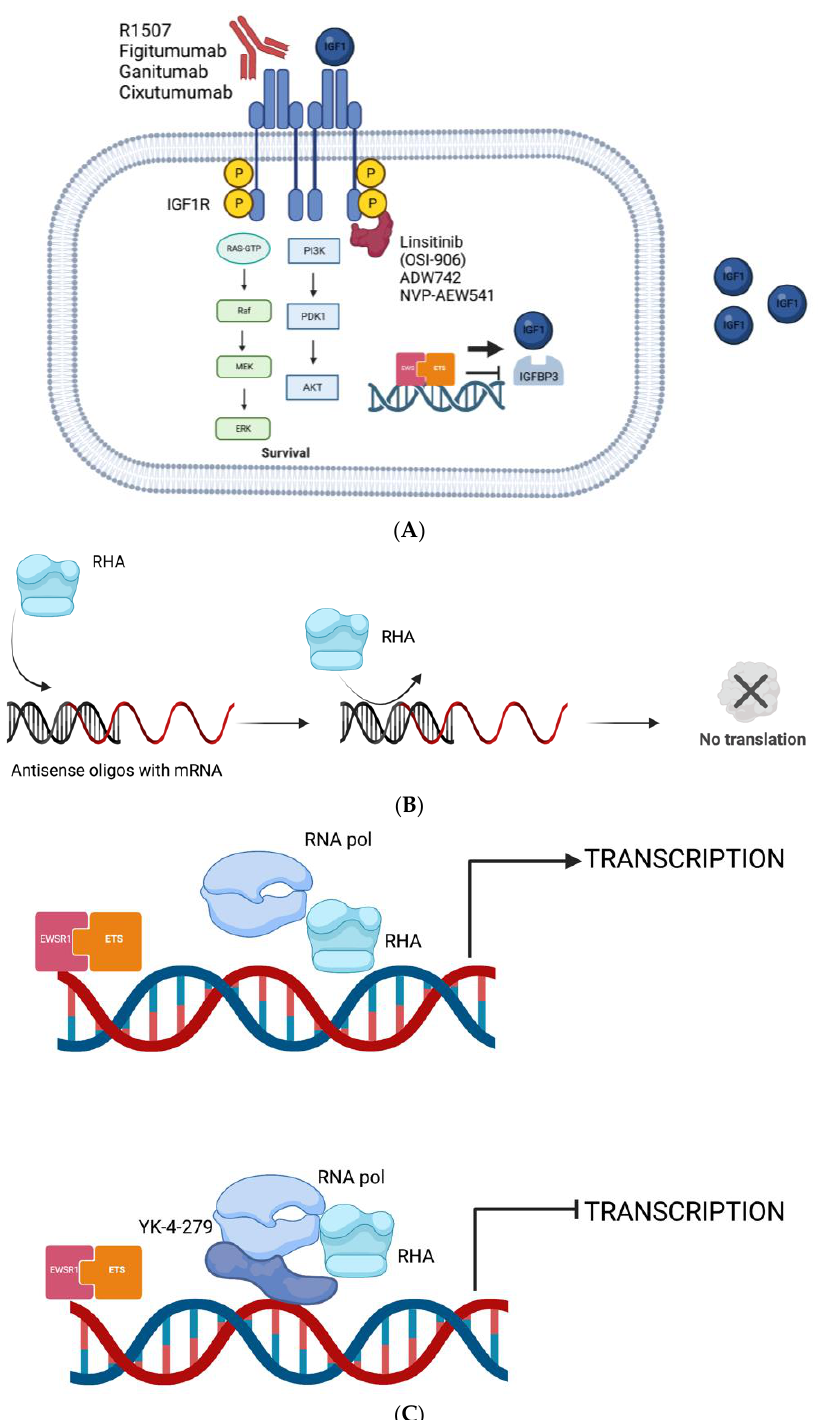
Figure 1. ( A ) EWSR1-ETS transcription activity enhances the transcription of IGF1 and reduces the transcription of IGFBP3; IGF1 binds to IGF1R and activates MAPK pathway leading to proliferation and survival; antibodies and small molecules that inhibit IGF1R signaling. ( B ) The mRNA, derived from the transcription of the fusion gene, is translated into the oncogenic fusion protein EWSR1-ETS that elicits its downstream effect; the mRNA translation process is stopped by oligos, and siRNAs and the fusion protein is no longer produced. ( C ) EWSR1-ETS depends on RHA to enhance its transcriptional activity; YK-4-279 can alter the interaction between EWSR1-ETS and RNAH resulting in transcription stop. (Created with BioRender.com).